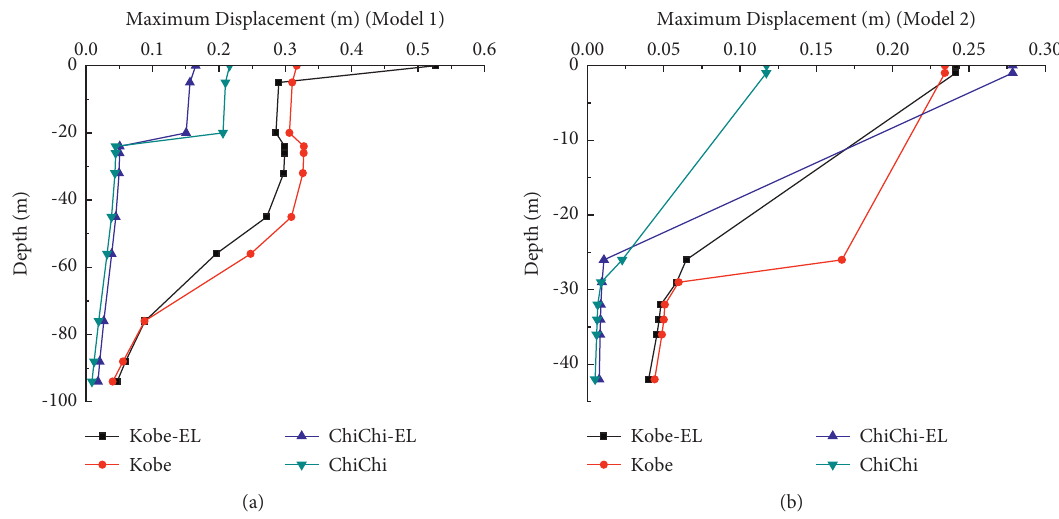
Figure 11: The maximum displacement of soil in (a) model 1 and (b) model